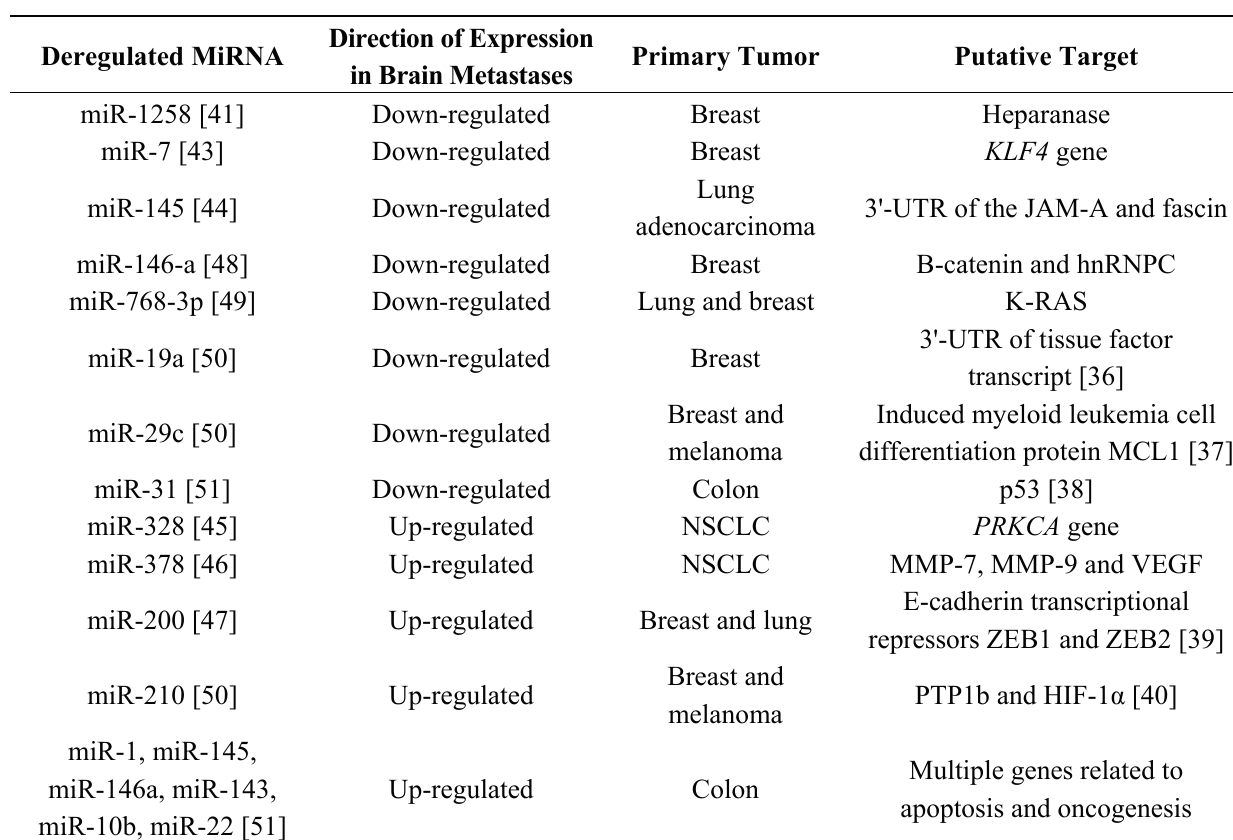
Table 1. MiRNAs deregulated in brain metastases compared to the primary tumor. Deregulated miRNAs identified in metastatic brain tumor cells compared to their matched primary tumors. NSCLC, non-small cell lung cancer; MMP, matrix